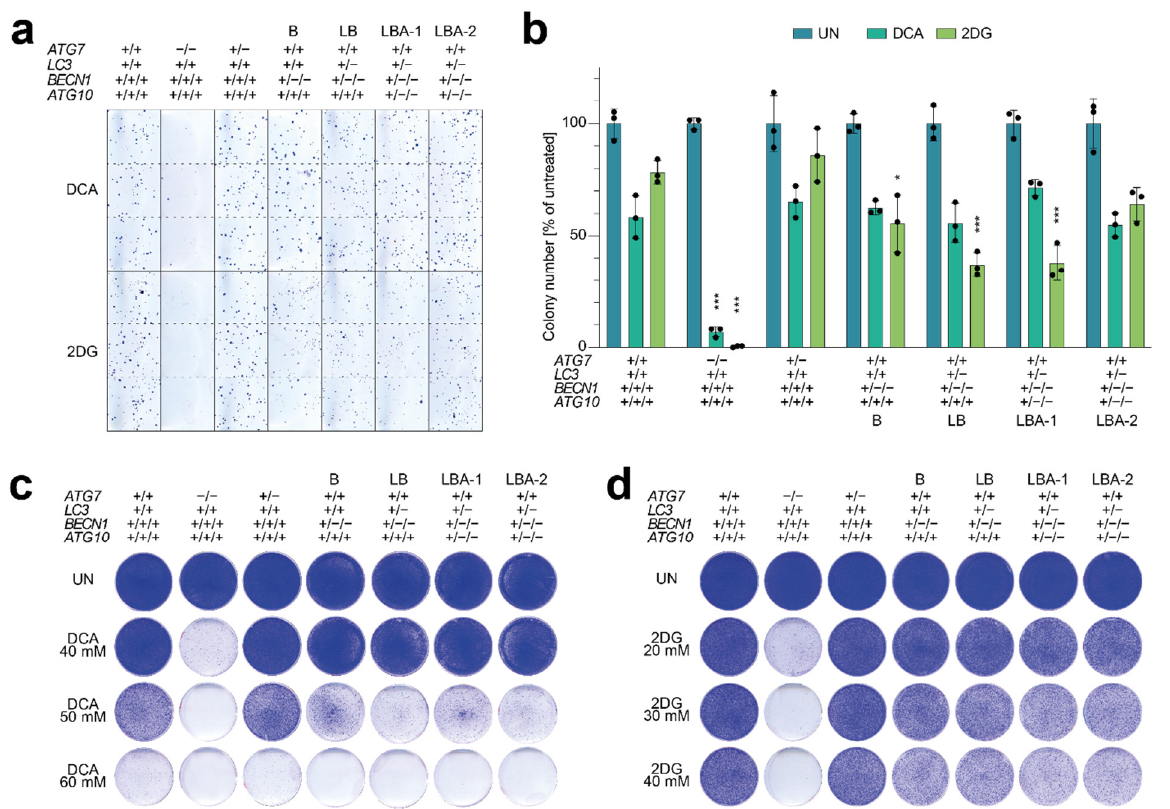
Figure 5. Tumor cells with copy number losses in multiple autophagy genes maintain clonogenic growth under metabolic stress. ( a , b ) Quantitative clonogenic growth assay. ( a ) Representative images. ( b ) Colony number in % of untreated cells. Shown is the mean ± SD ( n = 3). Differential treatment responses were tested for statistical significance by 2-way ANOVA and Dunnett’s multiple comparisons test. p -values denote pairwise comparisons of mutant with wild-type cells; ***, p < 0.0001; **, p < 0.001; and *, p < 0.01. ( c , d ) Clonogenic growth under increasing doses of ( c ) DCA and ( d ) 2DG. UN, untreated.